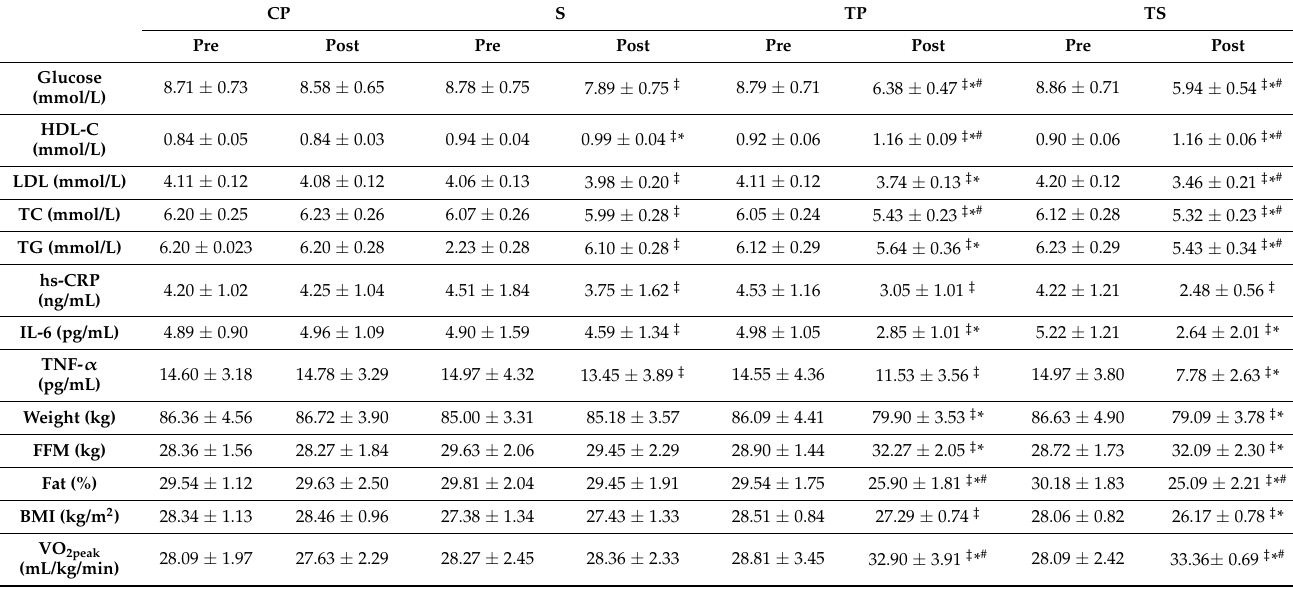
CP, Control–Placebo; S, Supplement; TP, Training–Placebo; TS, Training–Supplement; HDL, high-density lipoprotein; LDL, low-density lipoprotein; TC, total cholesterol; TG, triglyceride; hs-CRP, high-sensitivity C-reactive protein; IL-6, interleukin-6; TNF- α , tumor necrosis factor- α . FFM, fat free mass; FM, fat mass; BMI, body mass index. * indicates significant differences compared to the control group ( p < 0.05). # indicates significant differences compared to S group ( p < 0.05). ‡ indicated significant difference from baseline ( p <